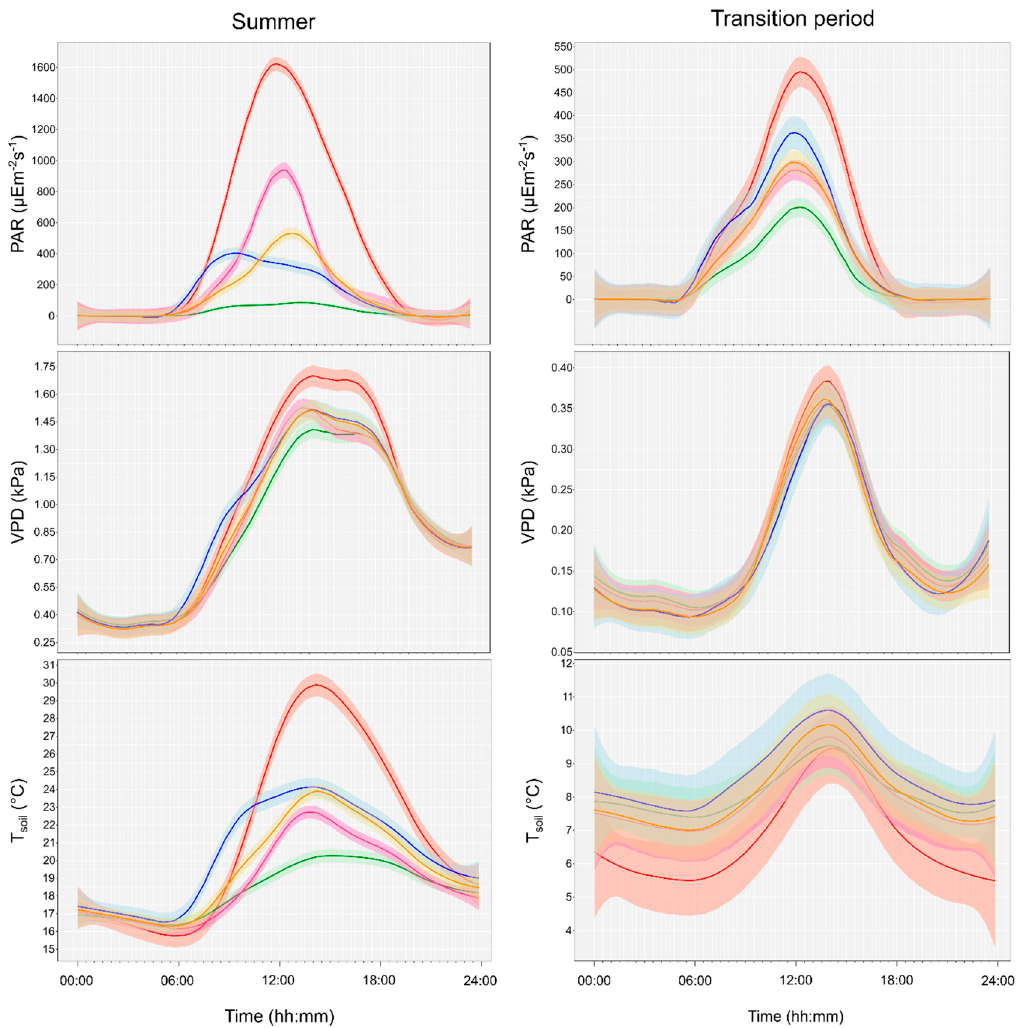
Figure 5. Diurnal patterns of selected microclimate variables. Diurnal magnitudes of PAR (photosynthetically active radiation), VPD (vapor pressure deficit) and T soil (soil temperature) among treatments in the peak of the growing season (i.e., June, July, August; left) and during the transition period (March, April, September, October; right), respectively. Lines represent means calculated by LOWESS function (based on the 6 replicates for each variable per month), bands represent 95% confidence intervals. Colors are coding the treatments: control—green; clear-cutting—red; gap-cutting—purple; preparation cutting—orange and retention tree group—blue. Note that scales of y-axes vary between graphs.